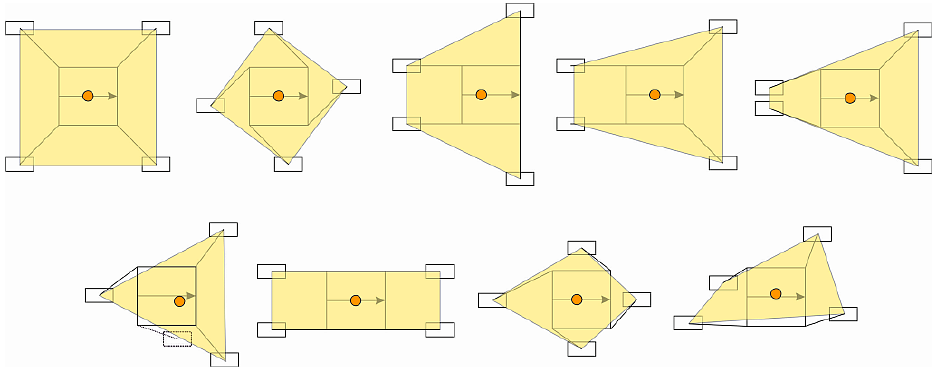
Figure 1. SherpaTT in soft sand dunes during Morocco field trials in 2018.